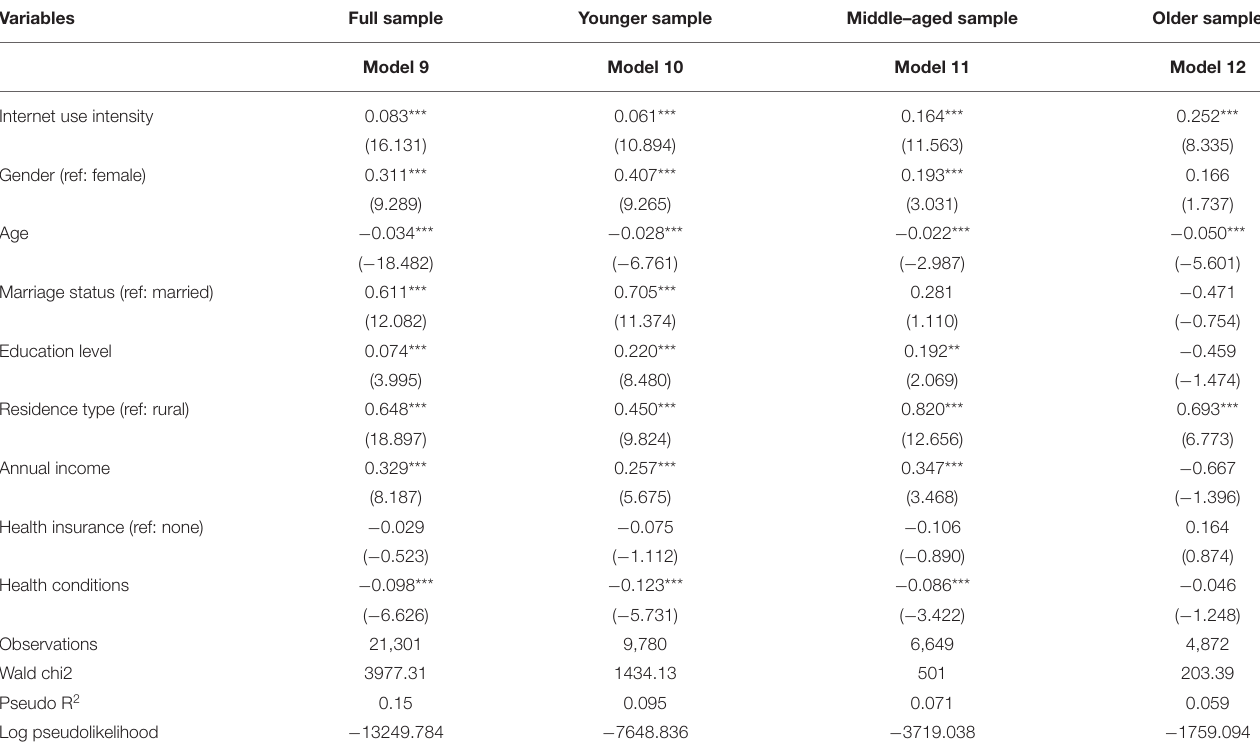
TABLE 5 | Results of the relationship between internet use intensity and stay up late ( N =